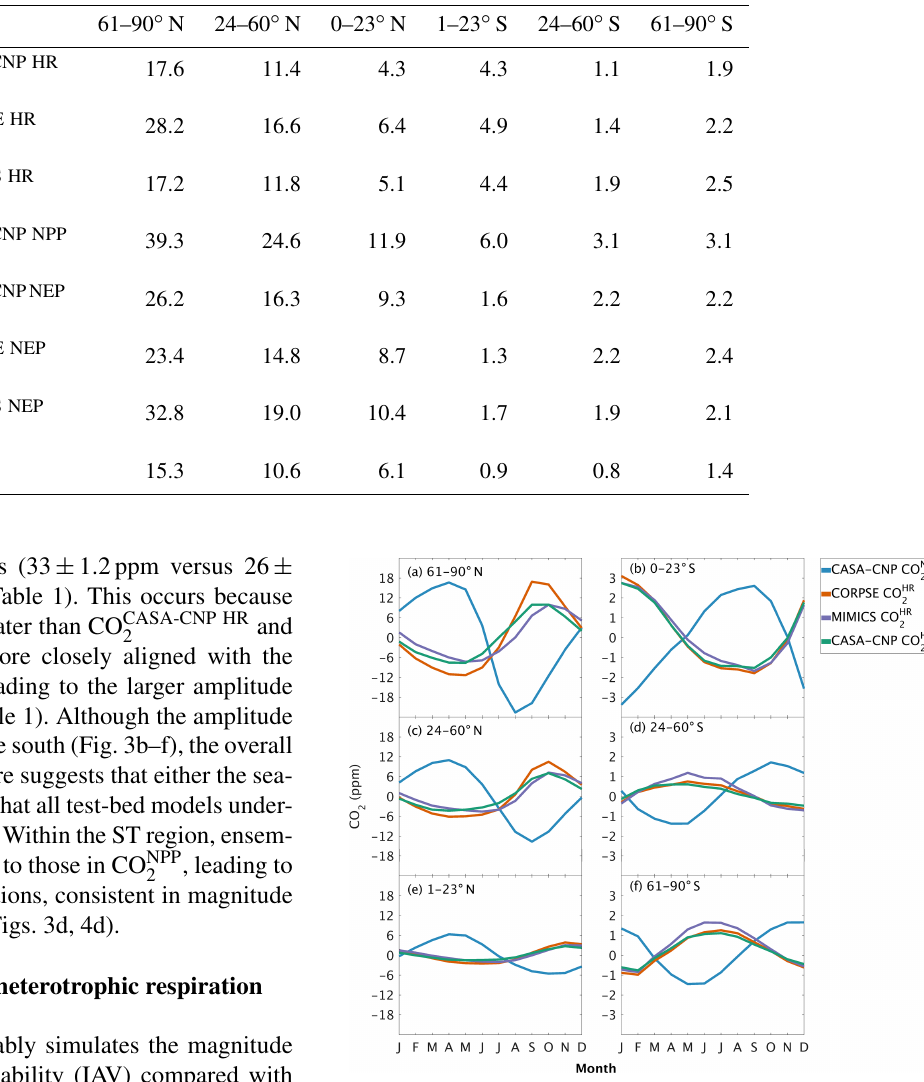
Table 1. Atmospheric CO 2 mean annual cycle amplitude (in ppm) simulated from heterotrophic respiration (HR), net primary productivity (NPP), and net ecosystem productivity (NEP). The median annual cycle amplitudes for observed CO 2 (CO OBS are also reported.